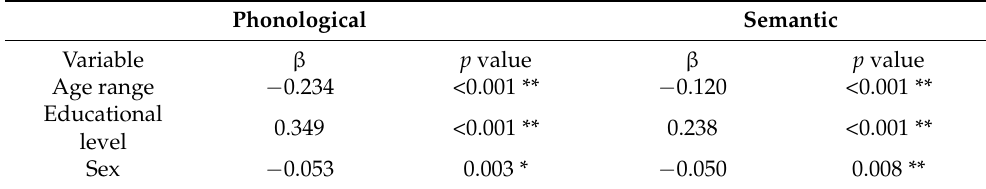
Table 7. Results of simple linear regression analysis to verify associations of verbal fluency with